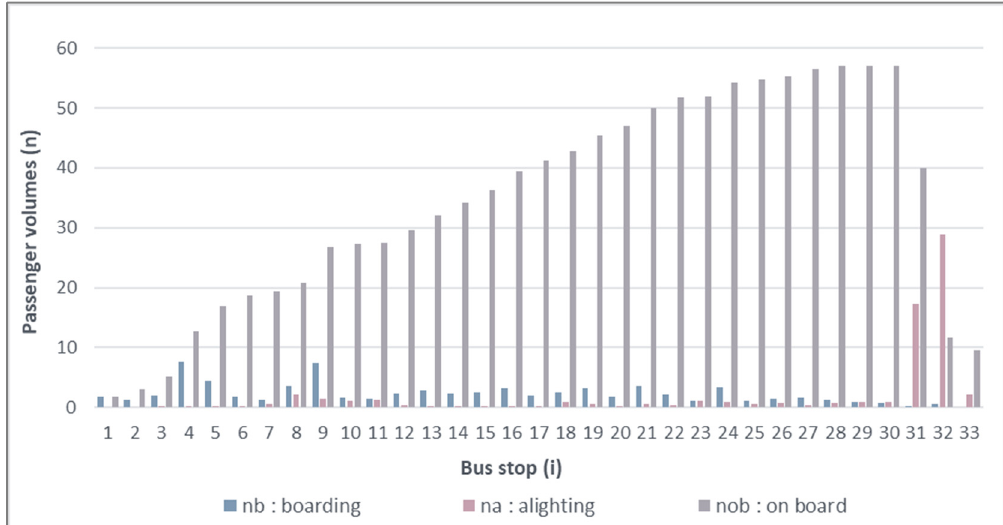
Figure 2. L171: Passenger flows along the line: Average number of boarding, alighting, and onboard passengers per stop.